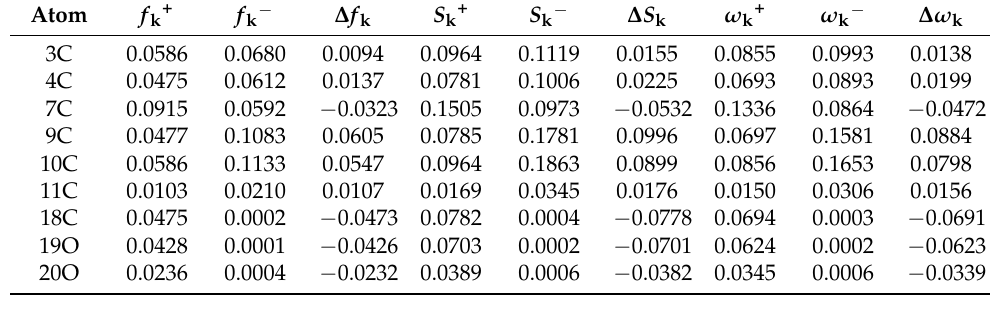
Figure 10. The lowest unoccupied molecular orbital (LUMO) of α -linoleic acid in the aqueous Figure 9. The highest occupied molecular orbital (HOMO) of α -linoleic acid in the aqueous phase. phase.